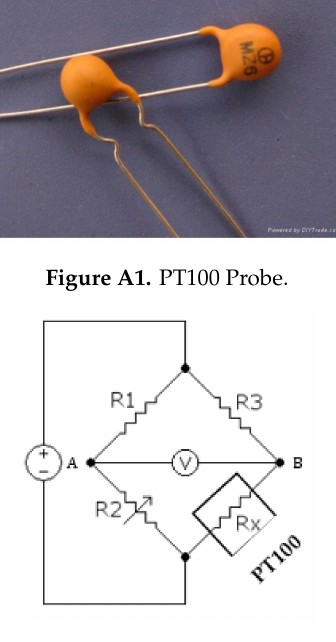
Figure A2. Wheatstone Bridge.